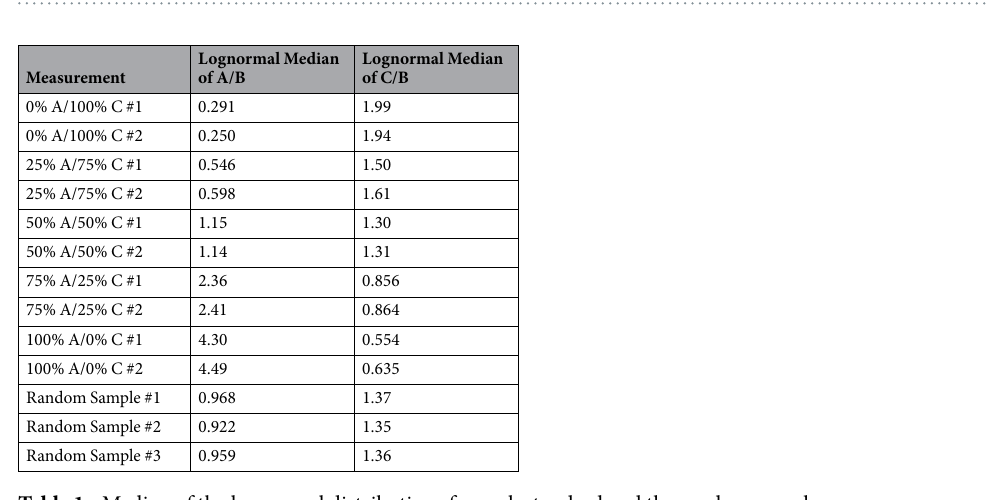
Table 1. Median of the lognormal distributions for each standard and the random